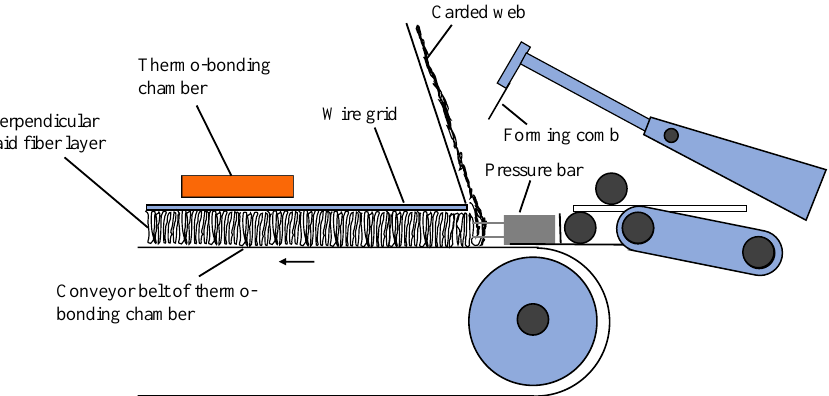
Figure 2. Sketch of perpendicular laying technology [17].